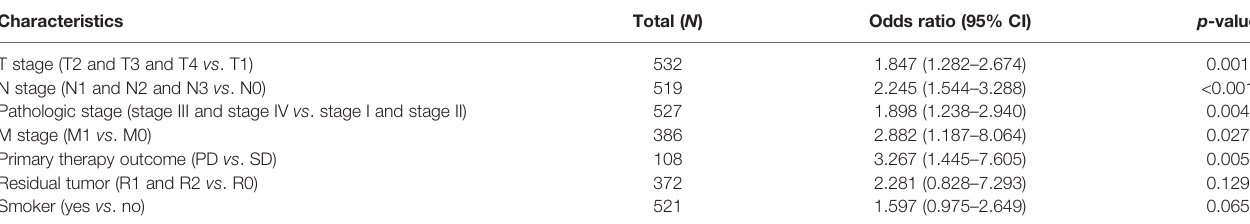
TABLE 1 | Correlation between hyaluronan-mediated motility receptor ( HMMR ) expression and the clinicopathological characteristics in TCGA-LUAD dataset. Characteristics Total ( N ) Odds ratio (95% CI) p -value T stage (T2 and T3 and T4 vs .